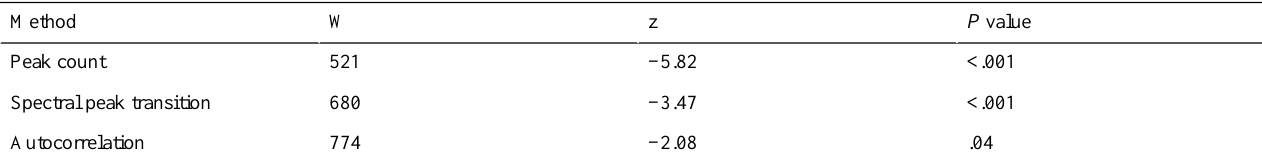
Table 2. Statistical evaluation of conventional algorithms using the Wilcoxon rank-sum